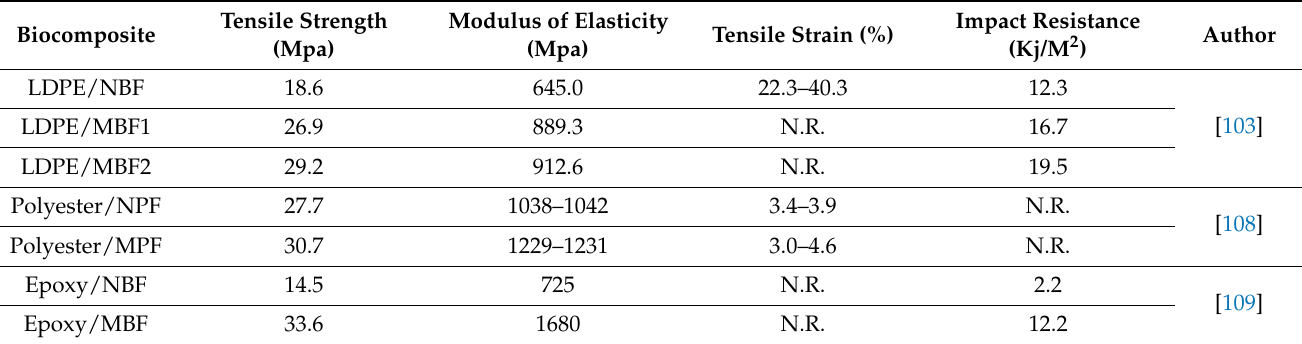
Table 7. Mechanical properties in biocomposites based on synthetic polymers derived from